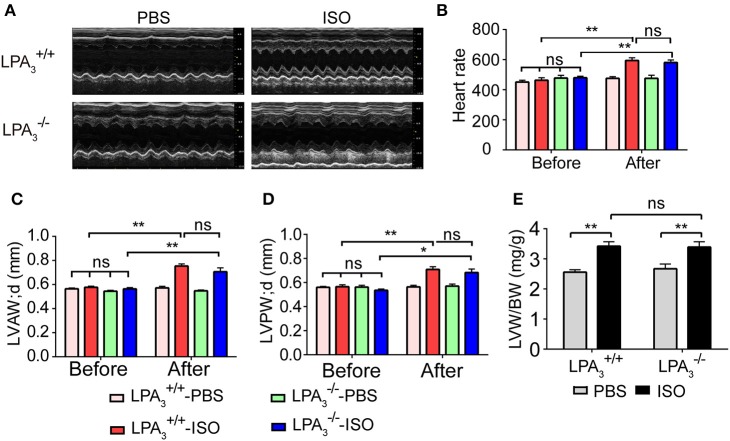
Loss of LPA3 does not affect echocardiographic parameters associated with ISO-induced cardiac hypertrophy. After ISO (60 mg/kg/d in PBS) or vehicle (PBS) infusion for 2 weeks, M-mode echocardiograms of hearts from wild-type or LPA3 knockout mice were recorded. Representative examples are shown in (A). Echocardiographic parameters including heartrate (B), LV diastolic anterior wall (LVAWd) (C), LV diastolic posterior wall (LVPWd) (D), and the left ventricular weight/body weight ratio (E) were measured. N = 8–11 mice per group. *p < 0.05, **p < 0.01, ns p > 0.05.